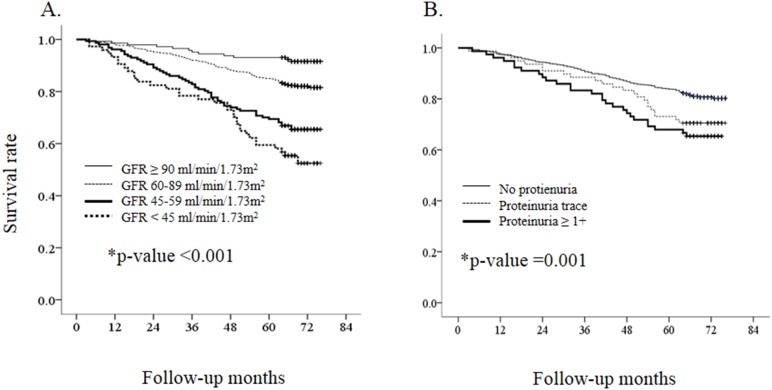
The survival rate according to GFR and proteinuria.A. GFR group for all-caused mortality. B. Proteinuria group for all-caused mortality *p-value by Log-rank test.